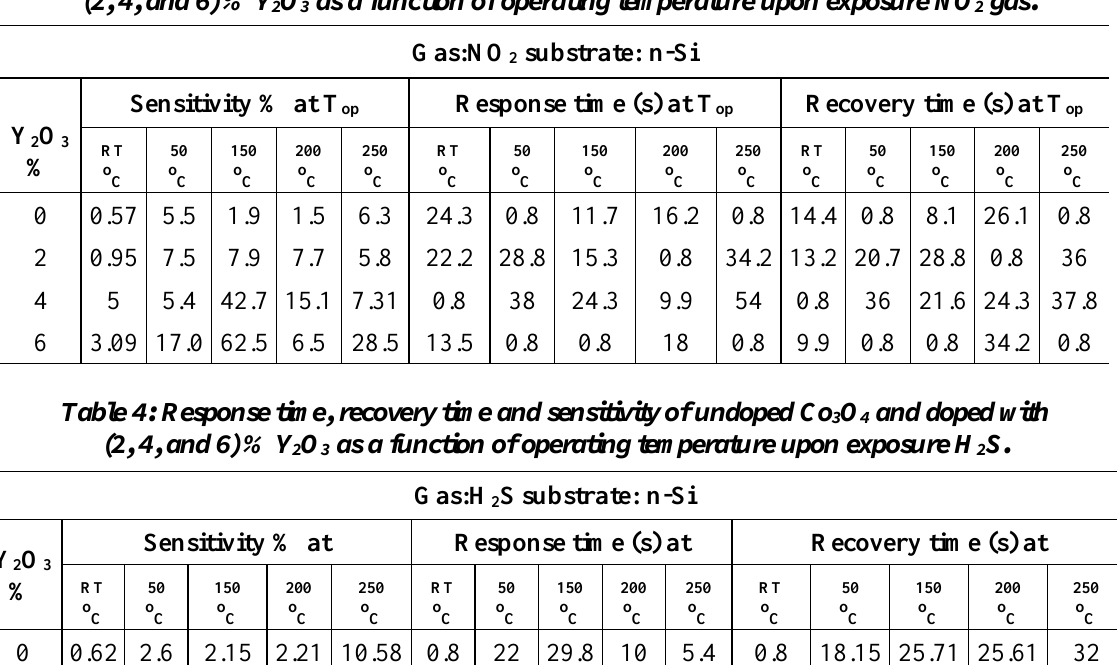
Table 3: Response time, recovery time and sensitivity of undoped Co (2, 4, and 6) % Y